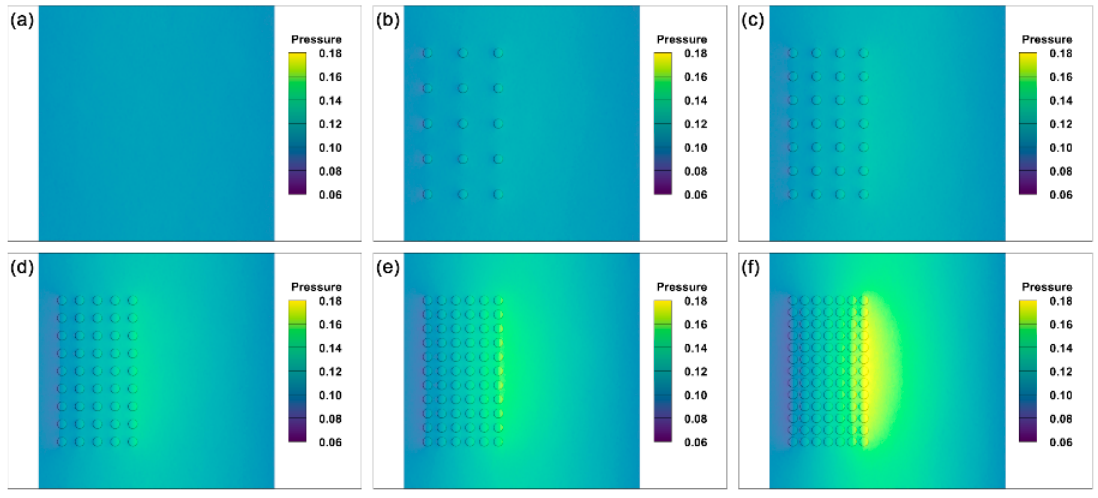
Figure 7. Pressure distributions on the top surface of the model for varying dimple densities: non-textured ( a ), 15 dimples ( b ), 28 dimples ( c ), 45 dimples ( d ), 66 dimples ( e ), and 91 dimples ( f